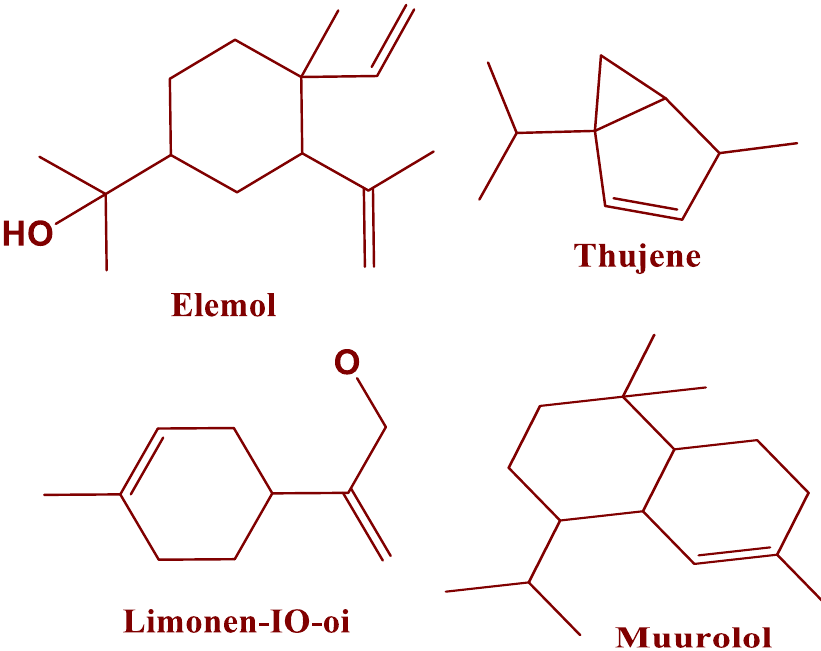
Figure 2. Molecular structures of phytochemical compounds in EOs of J. thurifera .